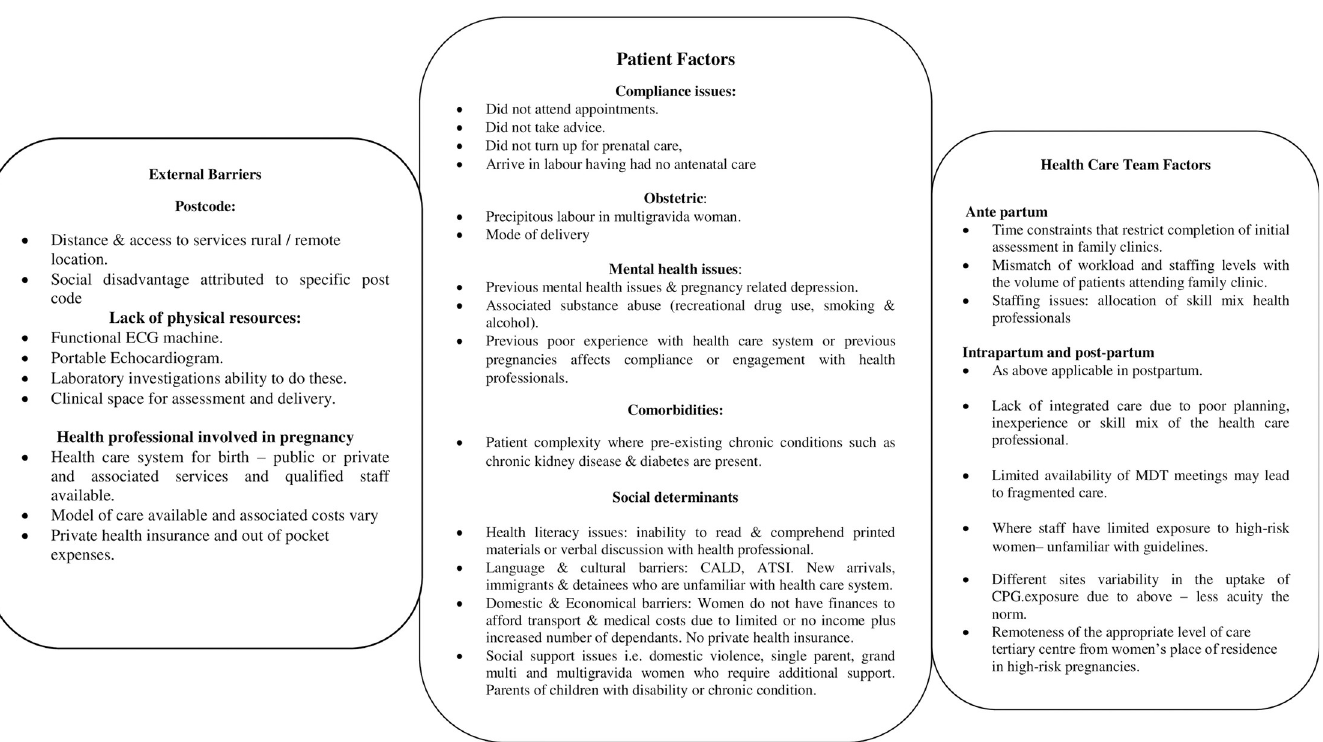
PLOS ONE | https://doi.org/10.1371/journal.pone.0230459 March 17,